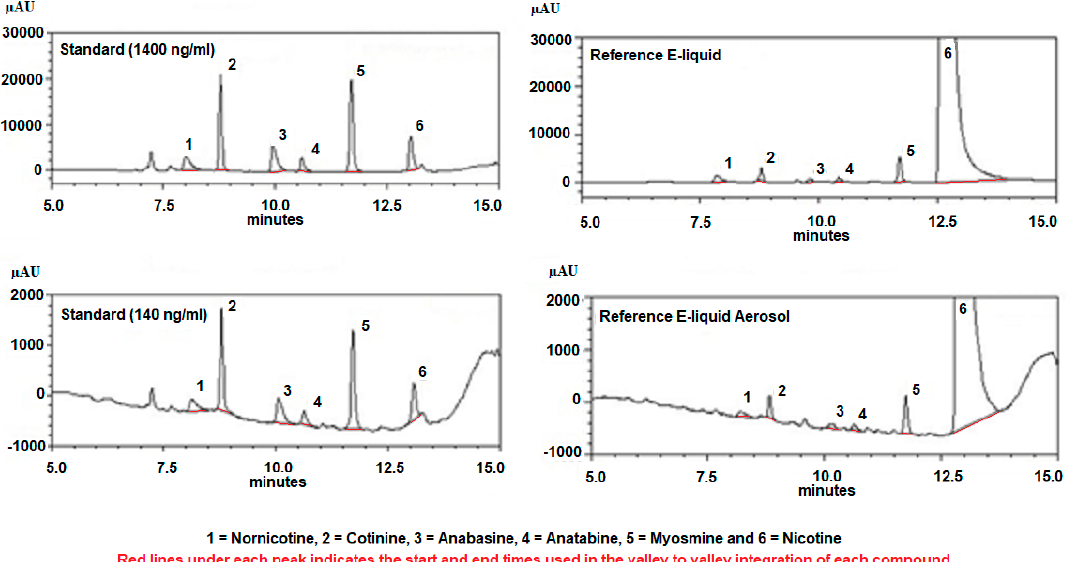
Figure 1. Representative chromatograms of standards and reference E-liquid and E-liquid aerosol.